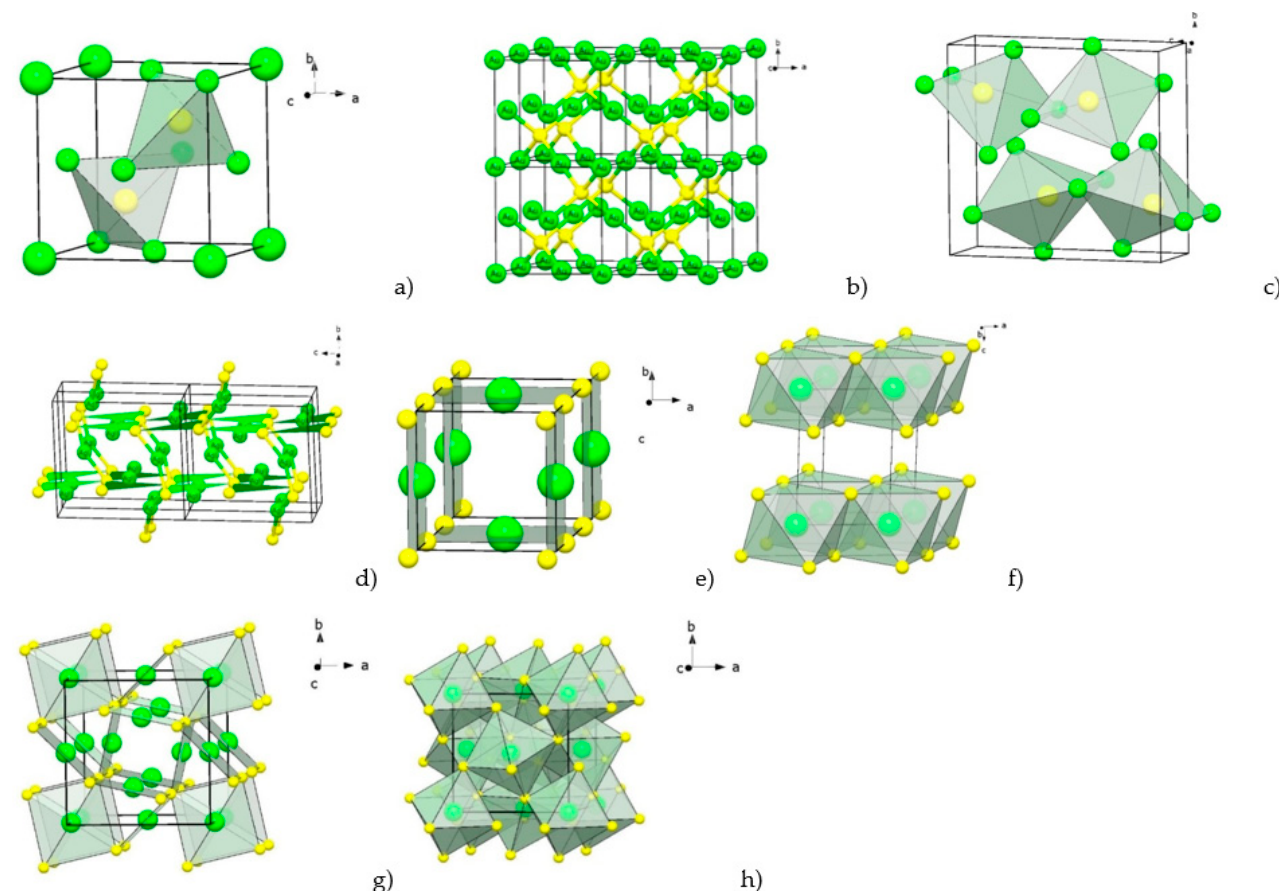
Figure 44. Crystal structures of NM-sulphides: ( a ) anion-centered polyhedra in the structure of Au 2 S, ( b ) three-dimensional framework of Au-S bonds in the Au 2 S, ( c ) anion-centered polyhedra in the structure of Ag 2 S, ( d ) cation-centered polyhedra in the structure of Ag 2 S, ( e ) crystal structure of PtS, ( f ) crystal structure of PtS 2 , ( g ) crystal structure of PdS, ( h ) crystal structure of PdS 2 . Table 31. Crystal chemical parameters of some noble metal sulphides.